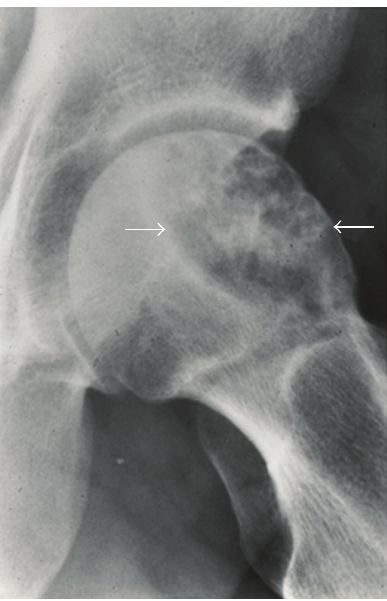
Figure 14: Clear cell CHS located in the epiphysis metaphysis of the proximal femur. The lesion is lytic, slightly expansile, and well delineated from the adjacent normal bone.